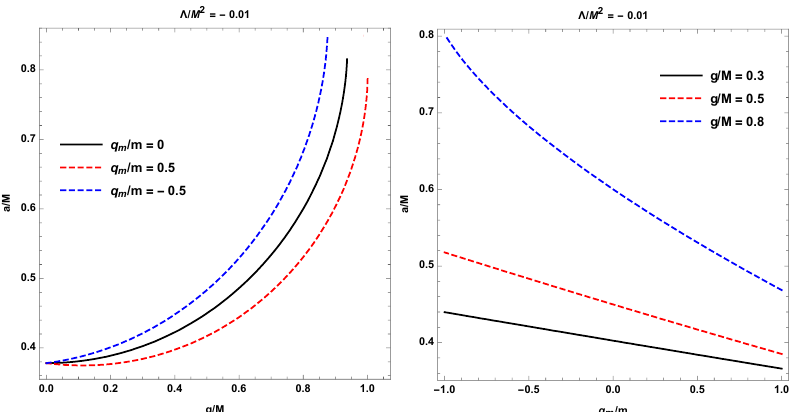
Figure 11. The degeneracy plots between the rotation parameter a and parameters g , Λ , and q m giving the same ISCO location for the magnetically charged test particle orbiting the regular black